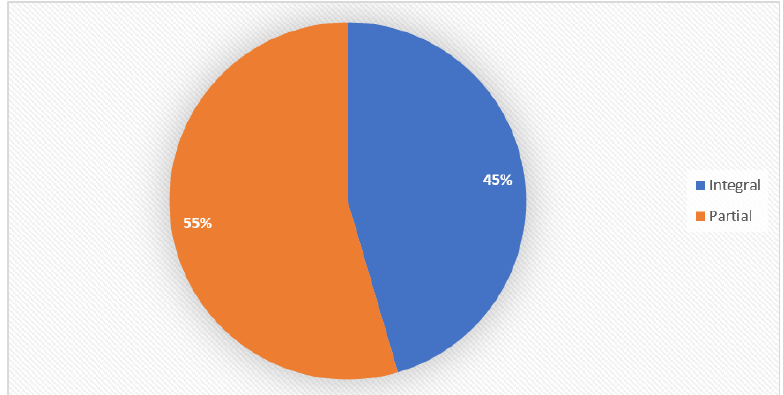
Figure 13. Degree of intervention. Own elaboration.